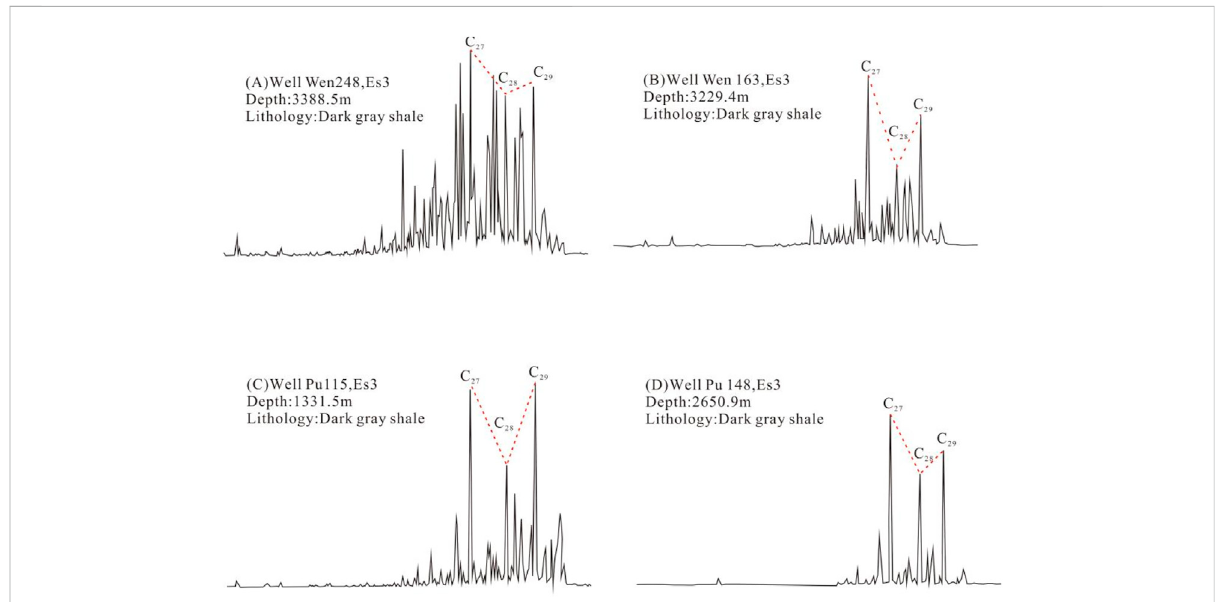
FIGURE 6 Typical biomarker combinations of source rocks in different zones of the Dongpu